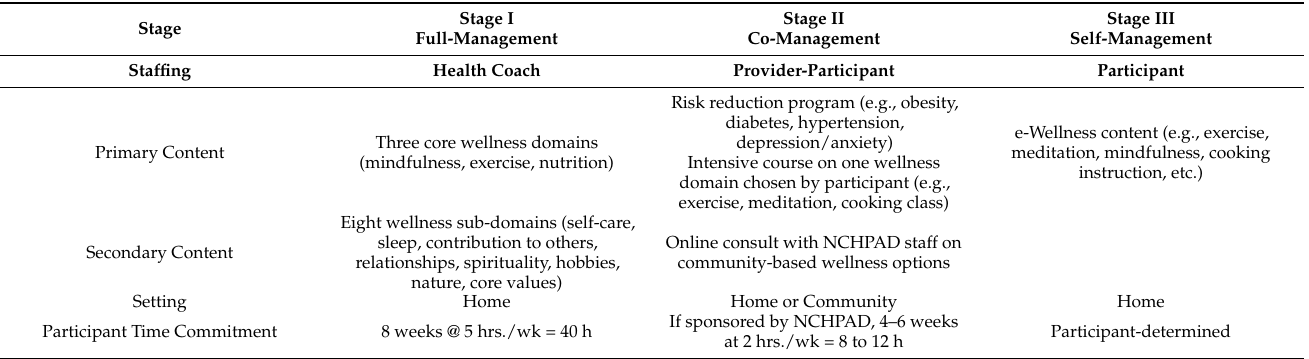
Table 1. NCHPAD’s stages of